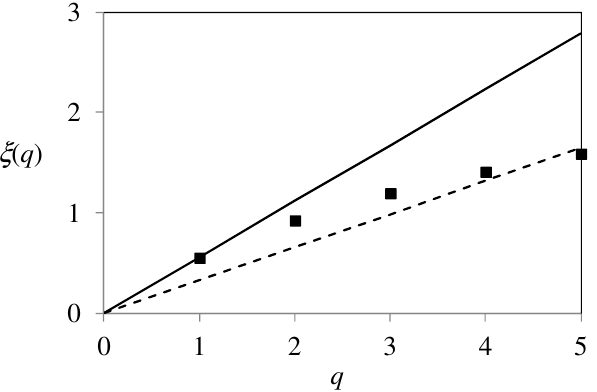
Fig. 7. ξ ( q) as a function of q (symbols) obtained via ESS based on ξ ( 1 ) = 0 . 56 computed for Arizona data by method of moments. Solid line has slope ξ ( 1 ) = 0 . 56 and dashed line slope H =0.33 estimated for these data based on our theory, using maximum like- lihood, by Riva et al.